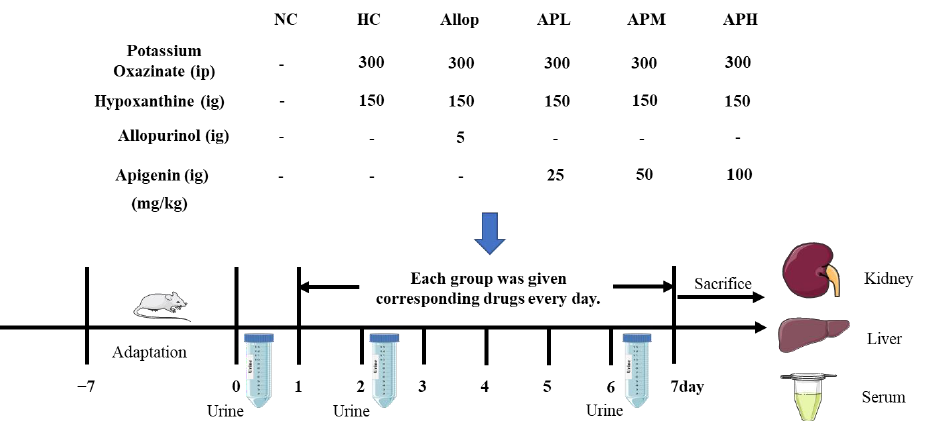
Figure 9. Experimental design on action of apigenin on acute HUA mice. ig denotes intragastrical administration, ip denotes intraperitoneal administration.